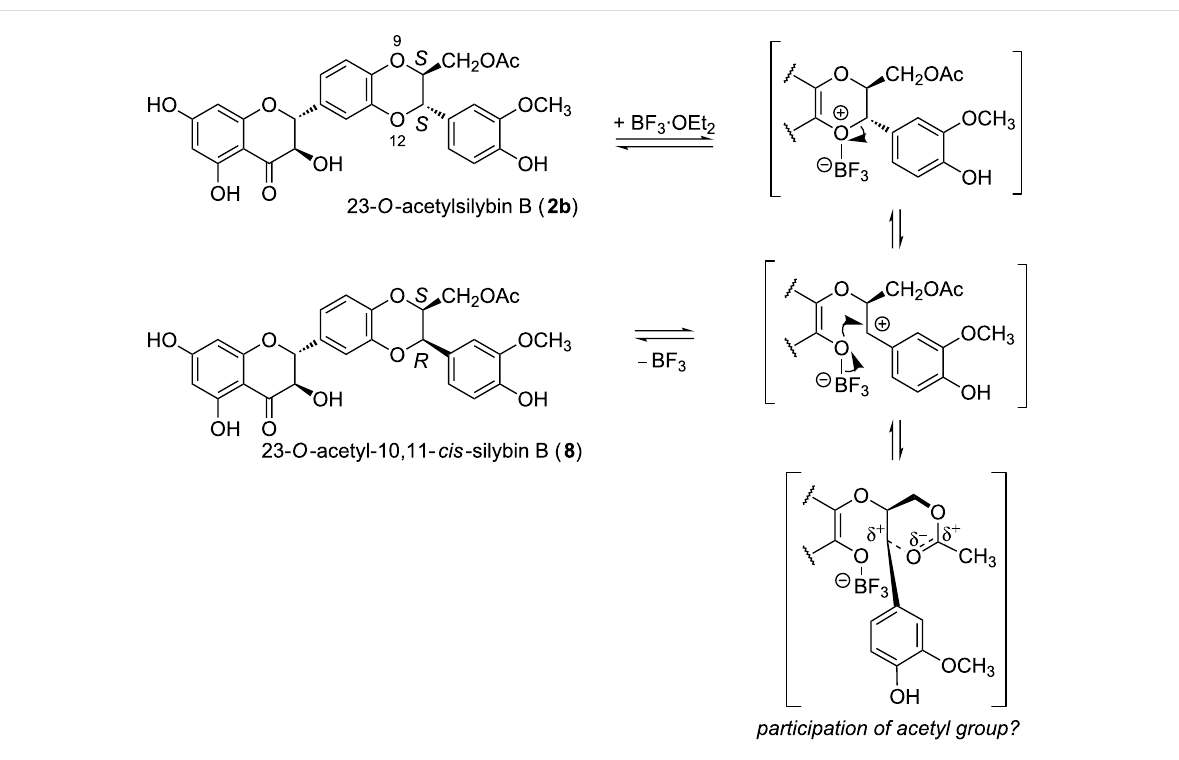
Scheme 6: Proposed mechanism of Lewis acid catalyzed isomerization of benzodioxane part of 23- O -acetylsilybin B ( 2b ) in